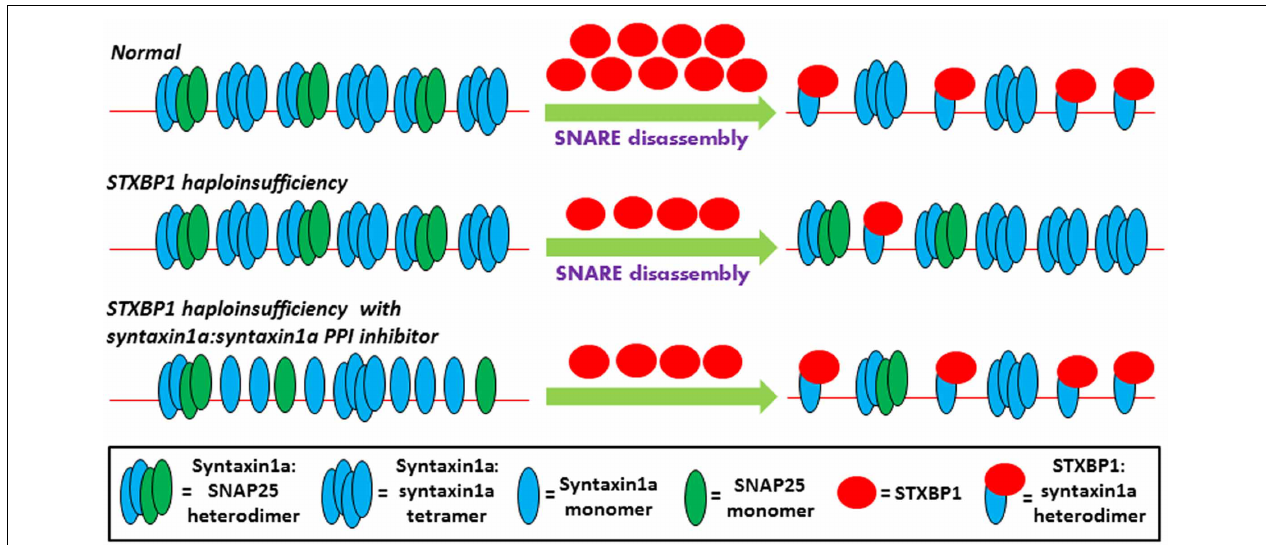
FIGURE 1 | Theoretical model of the early steps of the neurotransmitter release pathway is depicted in three scenarios. Under normal conditions, the presynaptic membrane, represented by the thin red line, contains non-productive SNARE complexes which are incapable of directly participating in membrane fusion and include syntaxin1a tetramers (Misura et al., 2001b), and syntaxin1a:SNAP25 heterodimers (Xiao et al., 2001; Misura et al., 2001a). Along with the N-ethylmaleimide-sensitive factor (NSF) and NSF adaptor proteins (Weber et al., 2000), not shown here for the sake of simplicity, STXBP1 is required for the disassembly of the non-productive complexes and the capturing of syntaxin1a monomers in their closed conformation. According to the findings of (Ma et al., 2013), these STXBP1:syntaxin1a heterodimers represent the true starting point of